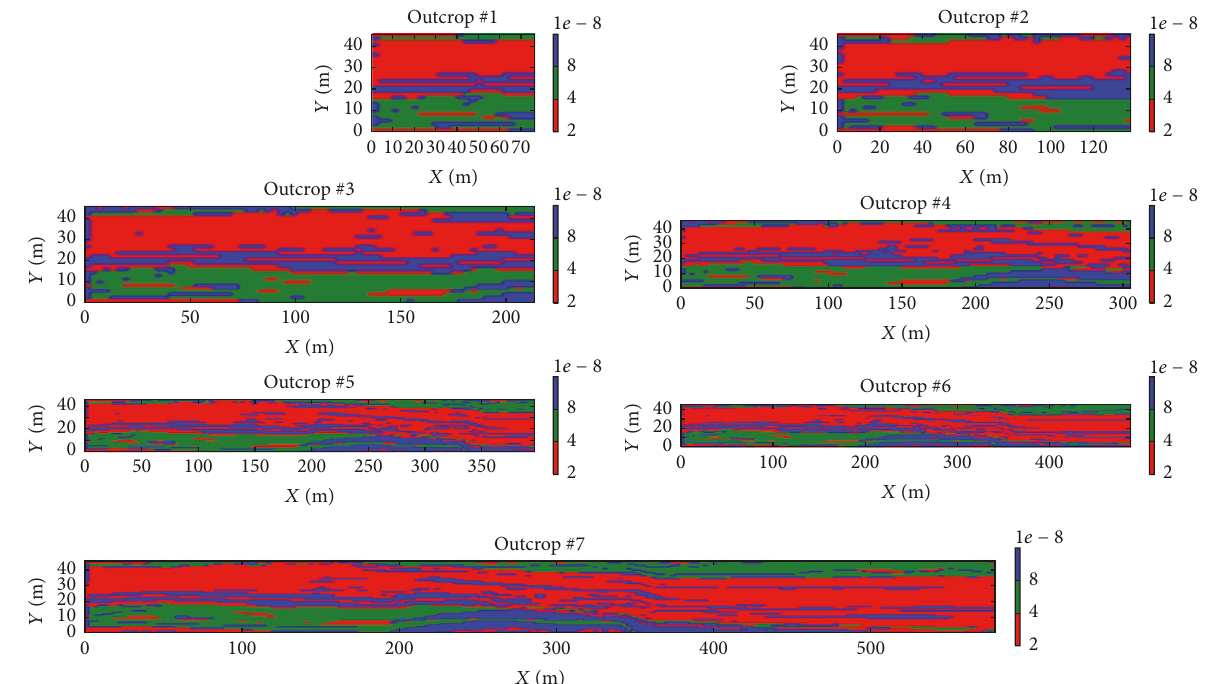
Figure 7: Irreversible retention rate constant (1/s) map for seven outcrops at field [78, 79].